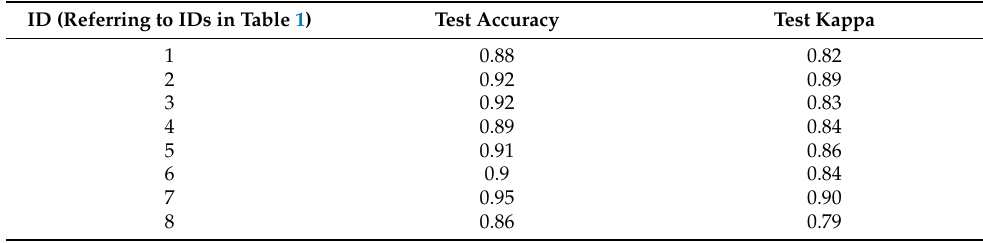
Table 2. Test accuracy and kappa: summary table of wildfire events considered as case studies. ID (Referring to IDs in Table